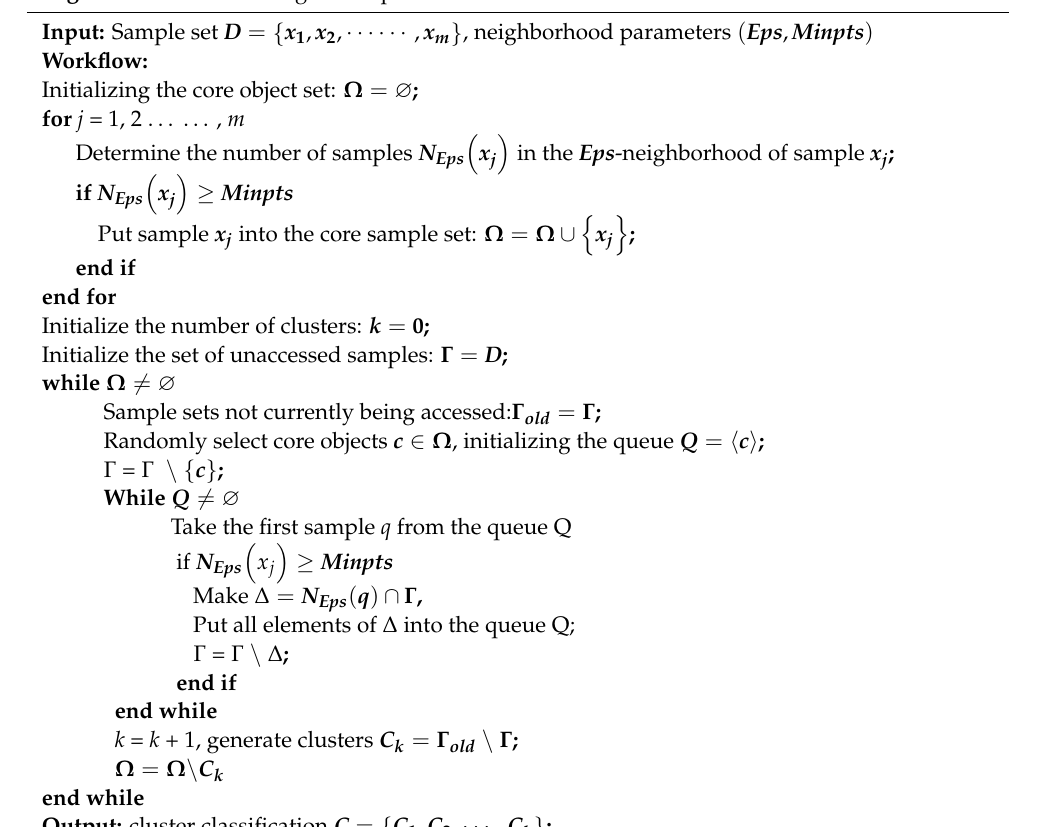
Algorithm 1 : DBSCAN algorithm